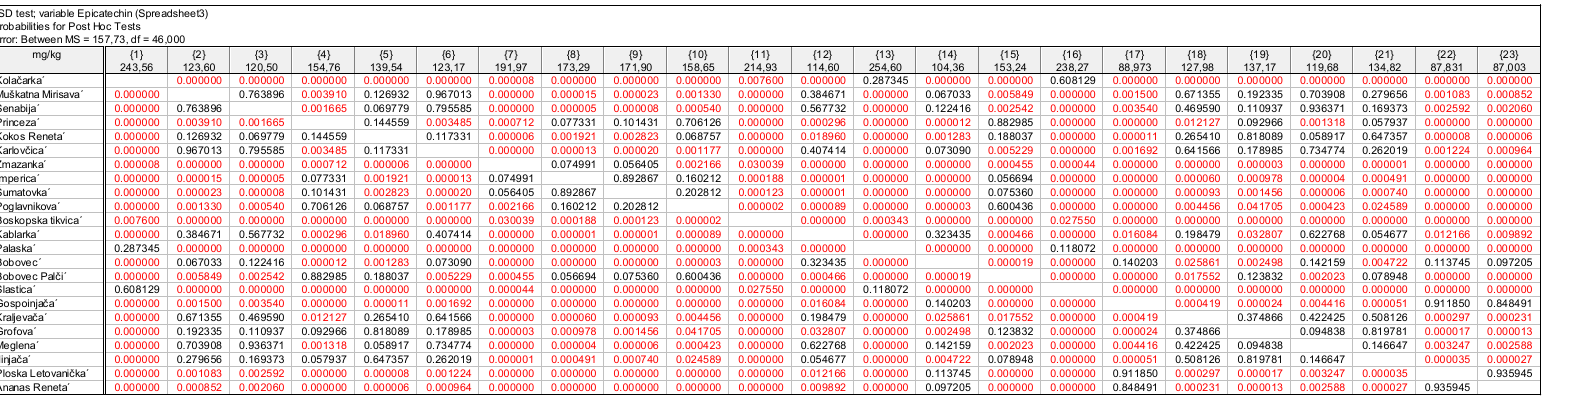
Figure A2. The statistical significance of epicatechin in traditional apple varieties; the p -values of the correlations of identified polyphenols. Statistically significant p -values are marked red ( p < 0.05).